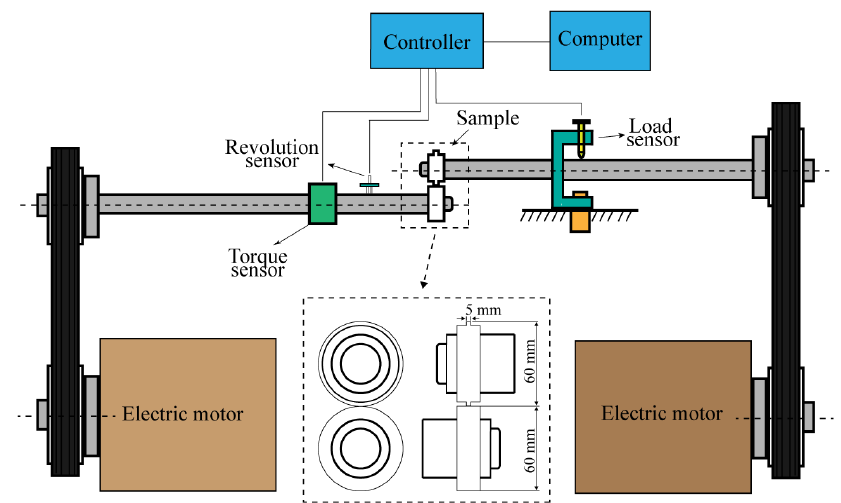
Figure 3. Experimental setup for the rolling-sliding tester.